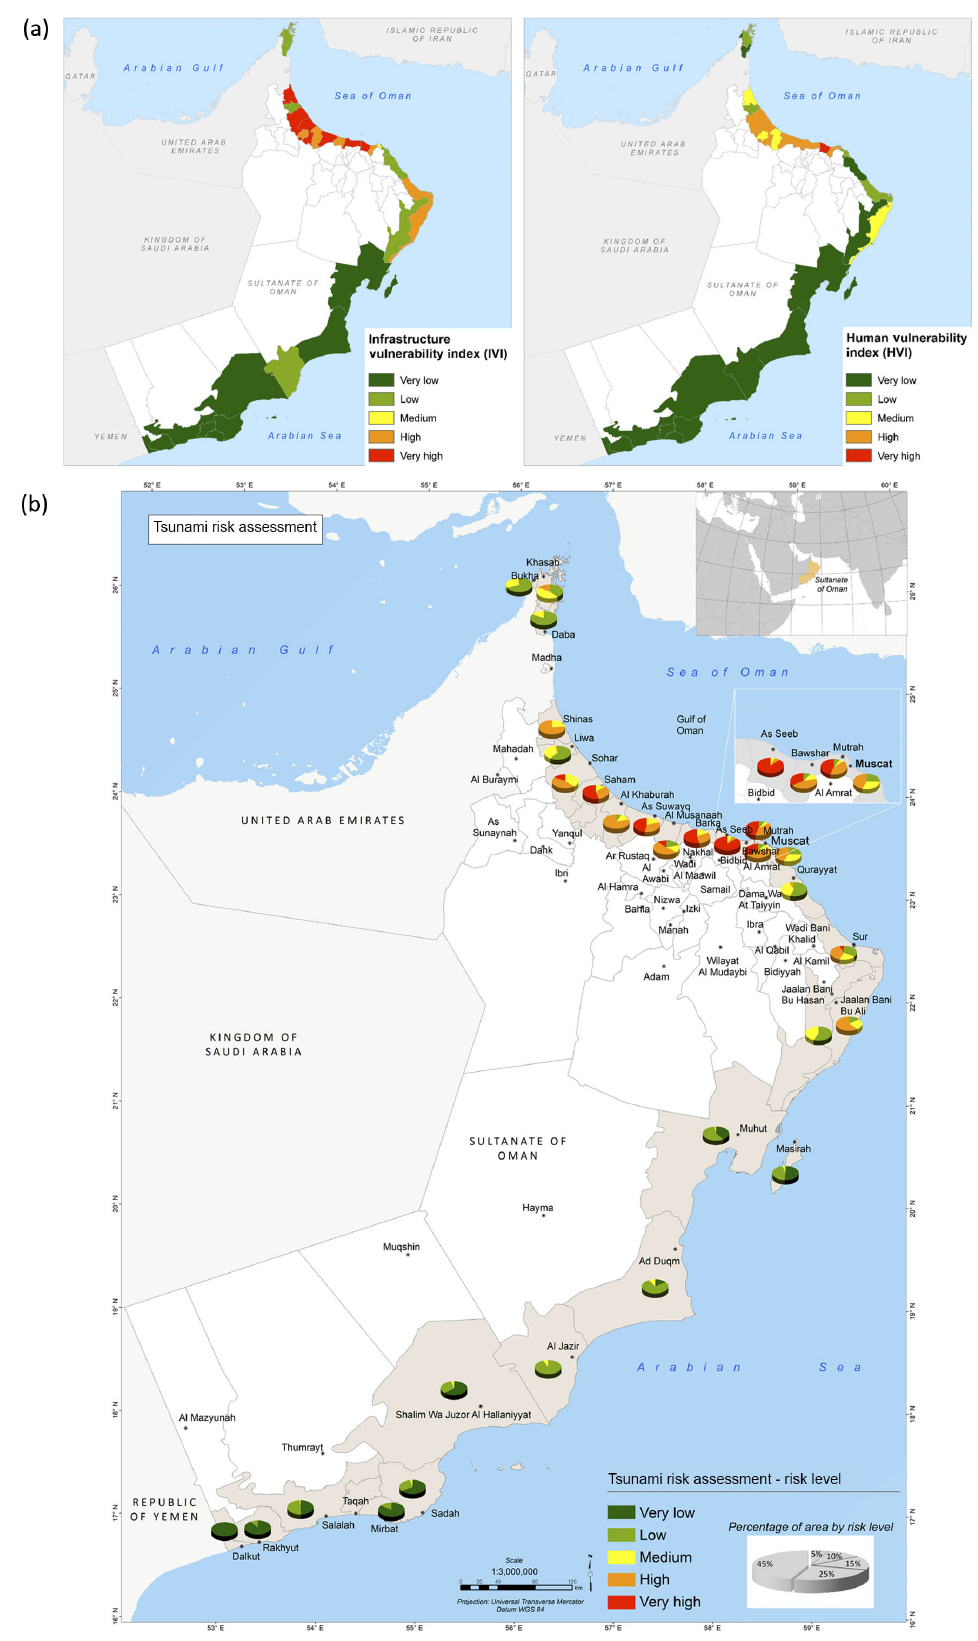
Figure 13. Infrastructure, human ( a ) and integrated ( b ) vulnerability assessments for the Oman coastline